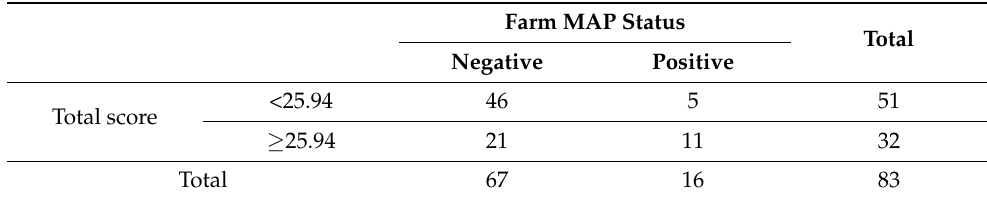
Table 2. Cross-classification of the MAP status of the farms (obtained from the laboratory tests performed as part of the control program) and the total score for the farms (obtained from the farm management practices according to the opinions of a group of experts).